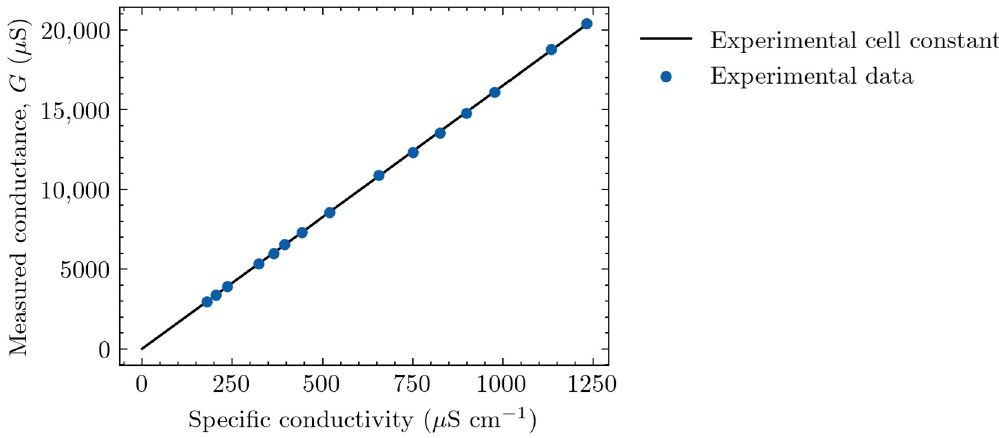
Figure 4. Measured conductivity cell conductance over a range of specific conductivities.